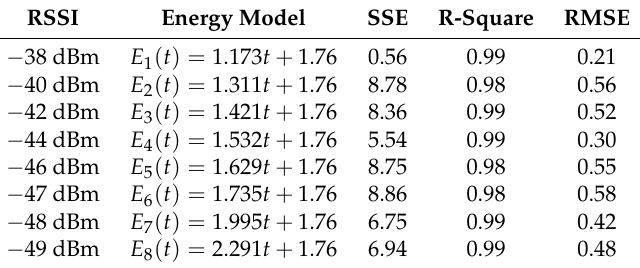
Table 2. RSSI, energy model and GoF test